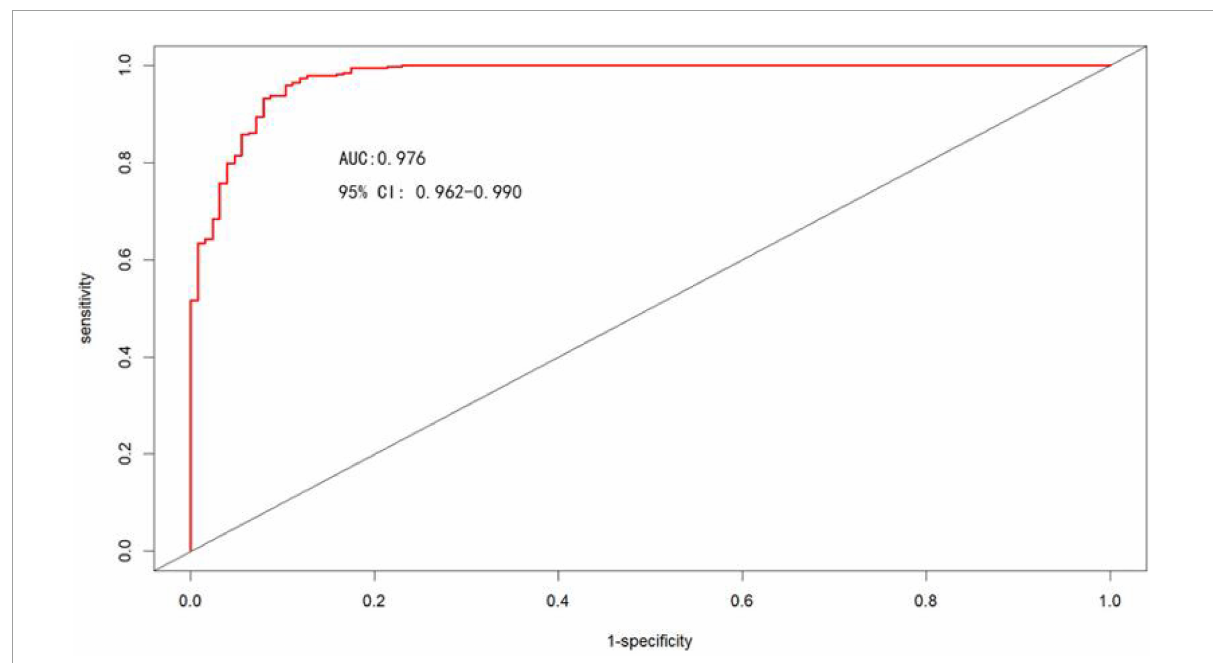
FIGURE5 ROC curves for the nomogram model to predict the risk of moderate-to-severe OSA occurrence.